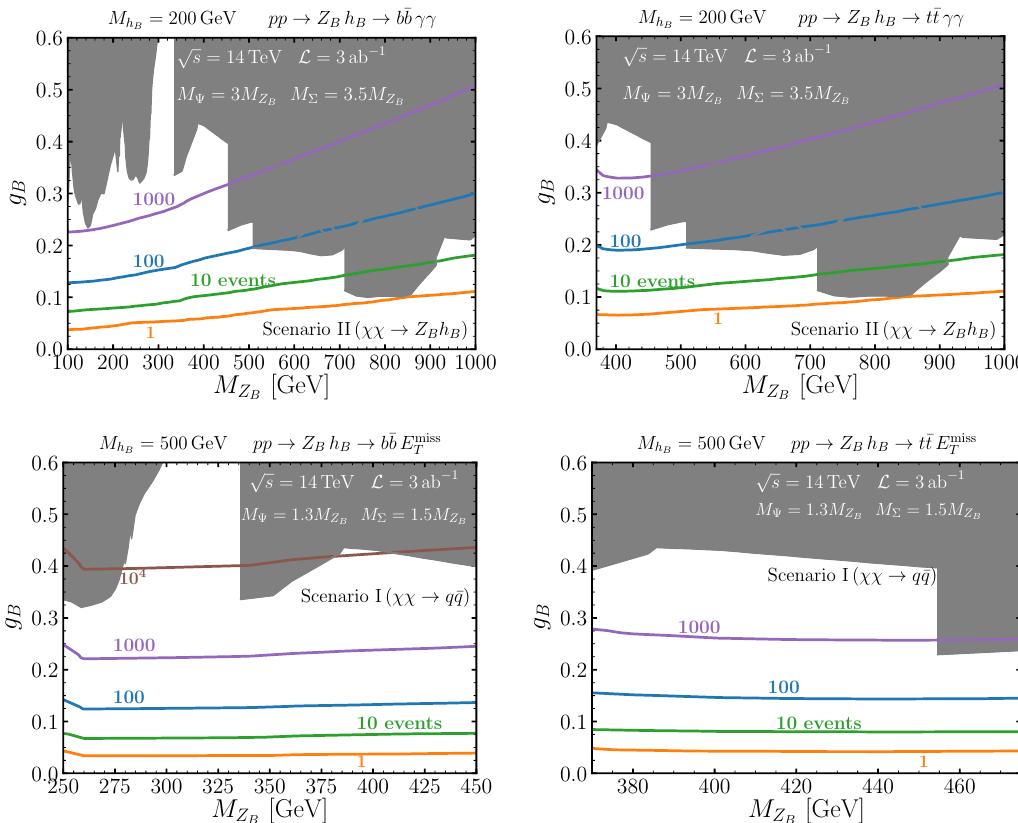
Figure 10 . Contour lines for the expected number of events at the LHC with center-of-mass energy of 14 TeV assuming an integrated luminosity of L = 3000 fb − 1 . We show the most relevant final states: for the upper panels we show b ¯ bγγ and t ¯ tγγ while for the lower panels we show b ¯ bE miss . In order to calculate the branching ratios of h t ¯ tE miss T scaled as the label shows on the plots. The gray region is excluded by the direct searches for a Z at the LHC. The scalar mixing angle is fixed to sin θ